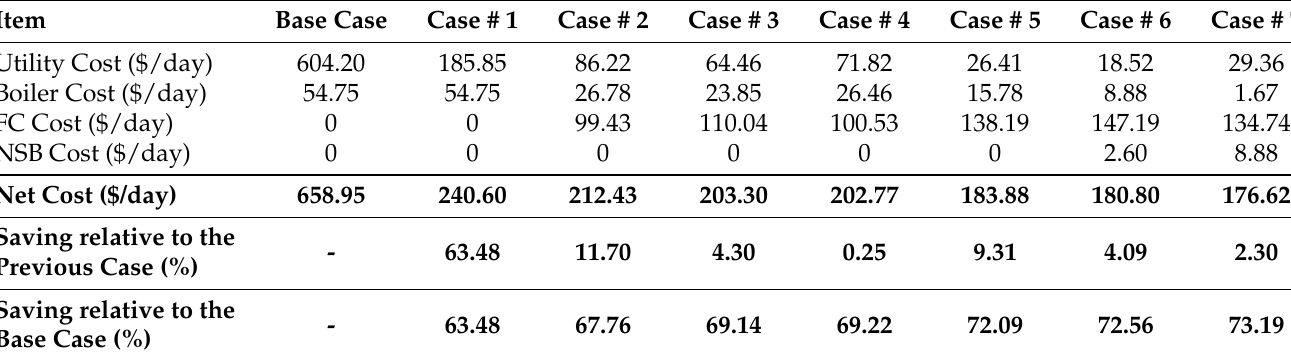
Figure 19. Thermal powers for Case 7. Table 5. Costs comparison table.